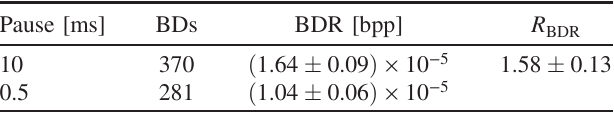
TABLE II. The results for the test with burst mode. R the BDR ratio with the lower repetition rate divided by that of the higher repetition rate. The uncertainties were estimated from the standard error of the mean and the propagation of